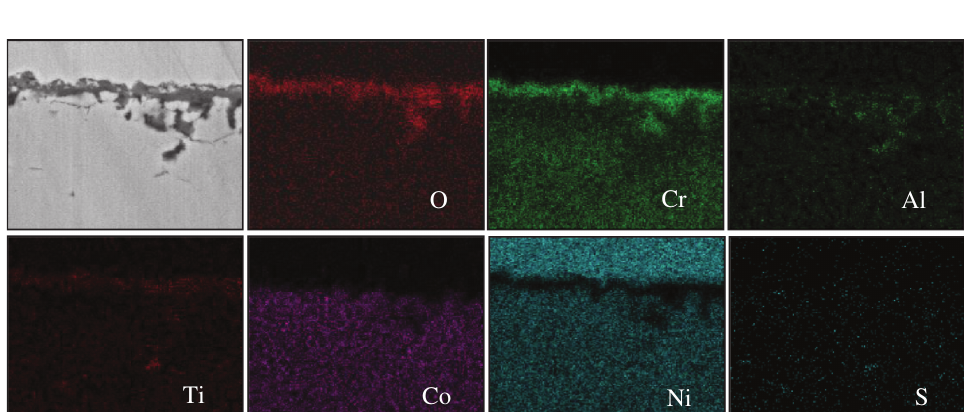
Figure 4: Surface and cross-sectional morphologies of tested samples corrode at 750°C for 500h, (a) (b) 0.1% SO 2 , (c) (d) 1.5% SO 2 , (e) (f) 1.5% SO 2 with NaCl addition.